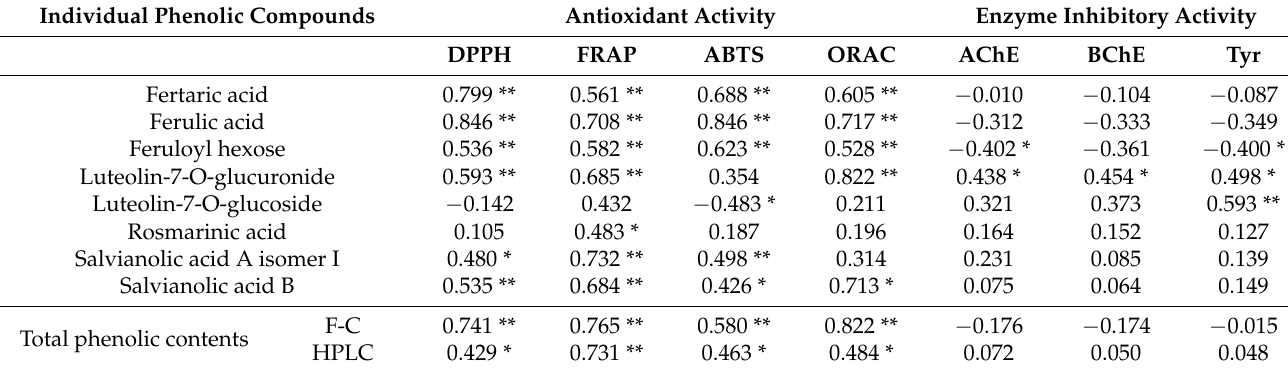
Table 3. Pearson’s correlation coefficients between antioxidant activity measured by the different assays (DPPH, FRAP, ABTS, and ORAC), enzyme inhibitory activities (AChE, BChE, and Tyr), total phenolic contents measured by F-C and HPLC, and individual phenolic